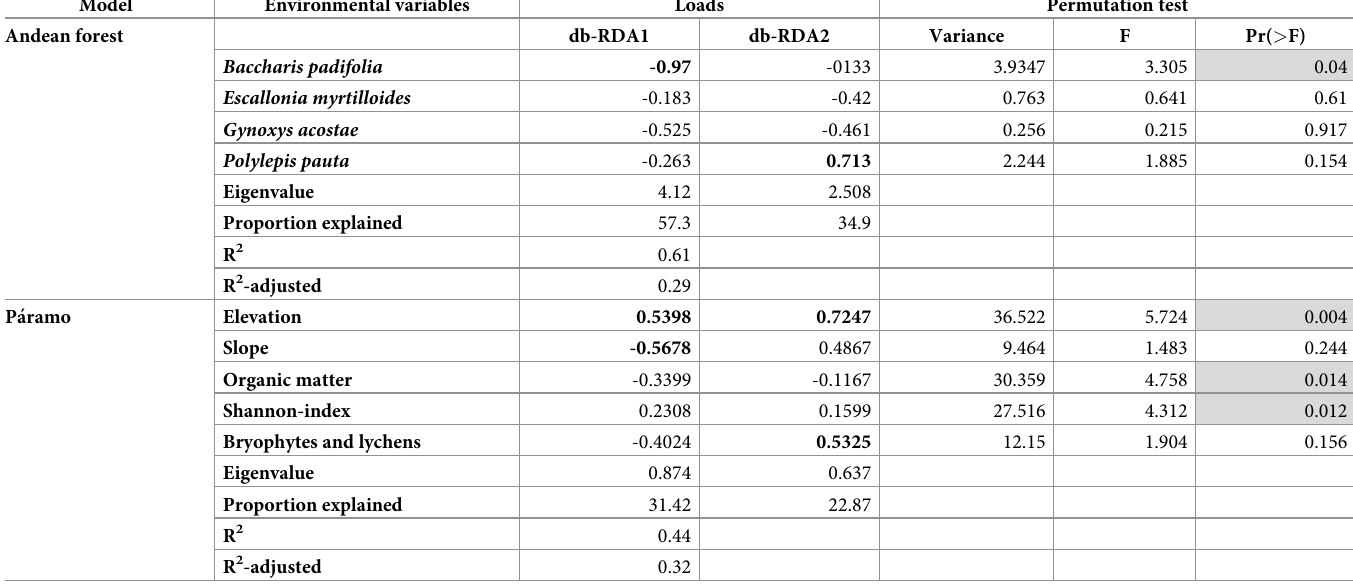
Bold values represent maximum load values, grey boxes represent the statistically significant variables to each model.